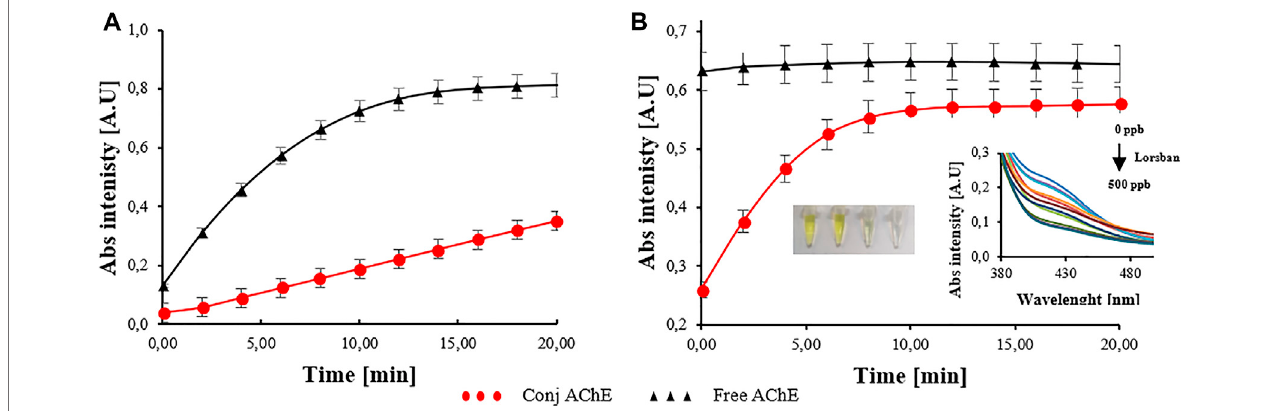
FIGURE 1 | Kinetic curves ofthe free and conjugated enzyme at different concentrations. (A) Acetylcholinesterase (AChE) at 1 U mL − 1 and (B) AChE at 5 U mL − 1 . The inset in (B) shows the linear inhibition of the free AChE at 5 U mL − 1 with increasing concentrations of Lorsban (0, 50, 100, 150, 200, 250, 300, 350, 400, 450 years 500 ppb). n = 4 independent